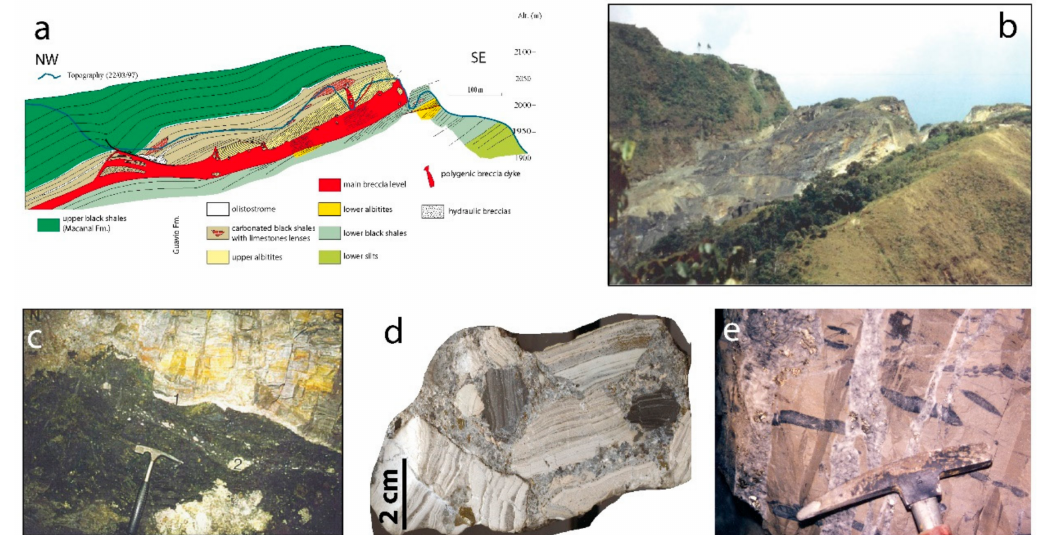
Figure 28. The Chivor mining area: ( a ) Geological cross-section through the Chivor emerald deposits; ( b ) south-eastern field view of the cross-section; ( c ) Chivor Klein pit. Upper contact of the main breccia level (in black) with albitites (1). The transport of clasts of albitite (2) within the breccia is marked by tails; ( d ) Oriente deposit. Polygenic breccia formed by clasts of albitite and black shales, cemented by pyrite, carbonates, and albite; ( e ) Oriente deposit. Carbonate-pyrite-emerald-bearing veins crosscutting albitite showing some remnants of black shale. Photographs b to d : Yannick Branquet; Photograph e : Gaston